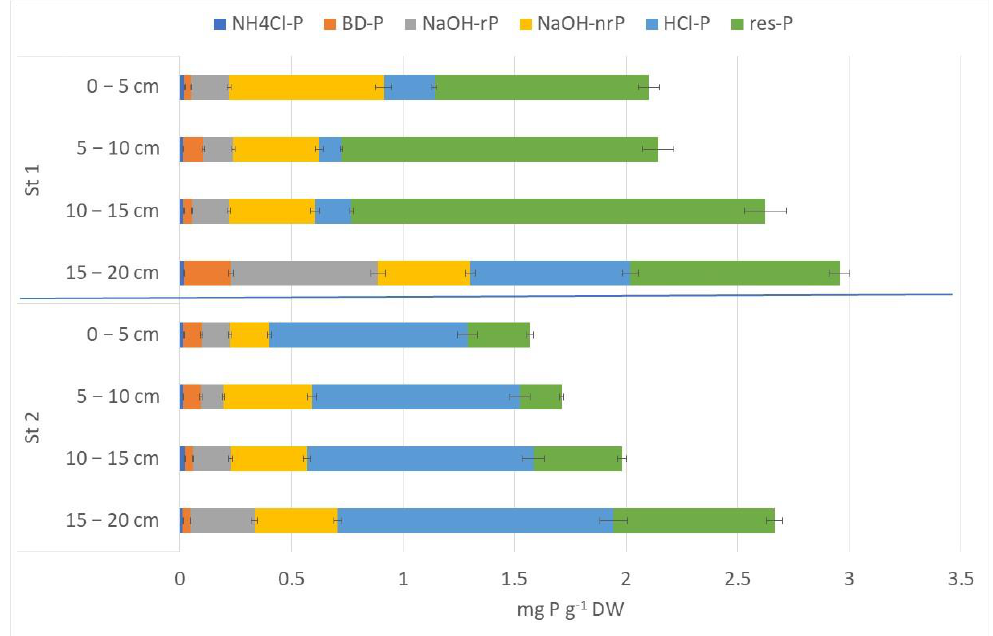
Figure 8. The amounts of P fractions (±SD) in the bottom sediment of Lake Kortowskie (total length of bars represents TP).